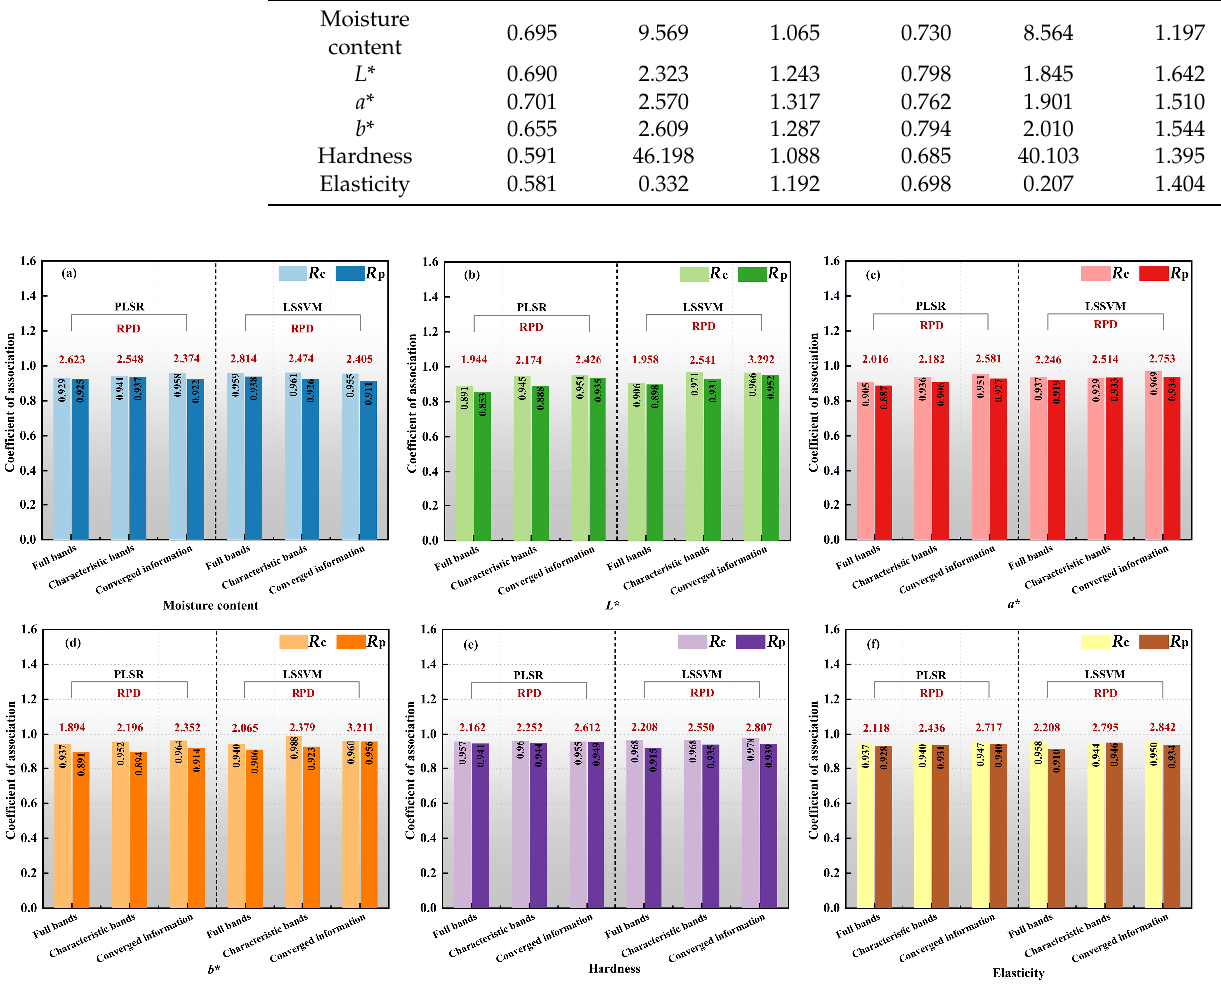
Figure 9. Comparison results of ( a ) moisture content, ( b ) L *, ( c ) a *, ( d ) b *, ( e ) hardness, and ( f ) elasticity models.